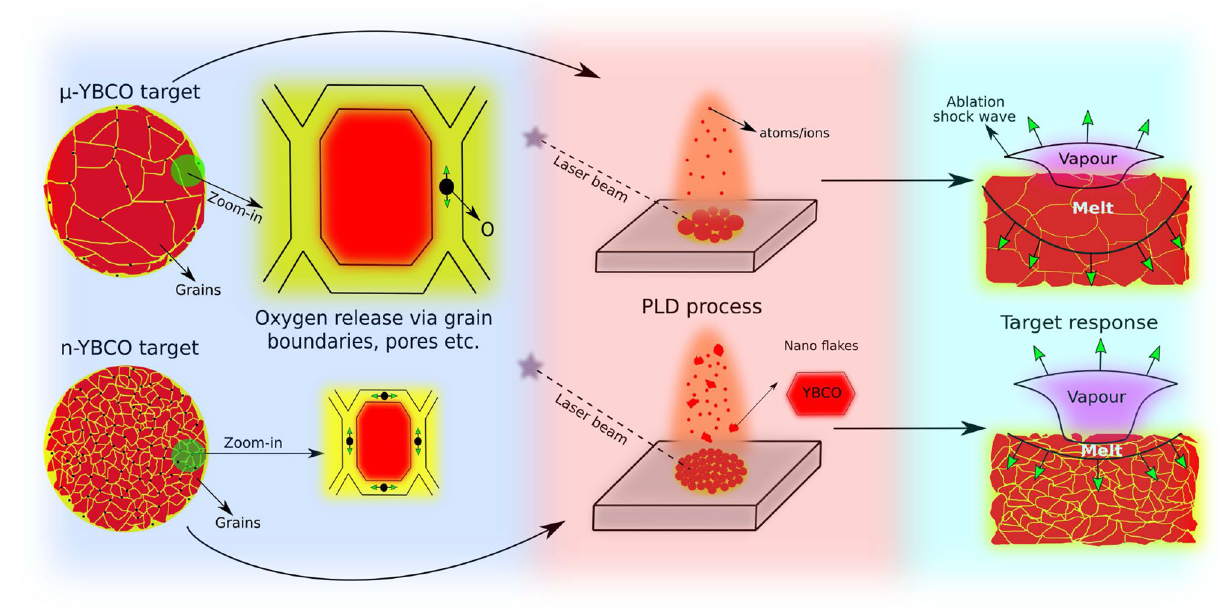
Figure 6. A proposed schematic illustration how nanograined and micrograined YBCO targets lead to different ablation mechanisms. The original target grain size together with differences in the number of grain boundaries and through the grain boundaries released oxygen (on the left) affect the modified laser–target interaction. Since the laser energy is concentrated on the surface layer in n-YBCO target, the melting process is faster, leading to more powerful removal of YBCO (on the right). These mechanisms result in a smooth plume of individual atoms and ions in µ -YBCO, while in n-YBCO a great number of larger fragments of YBCO nanoparticles occur (in the